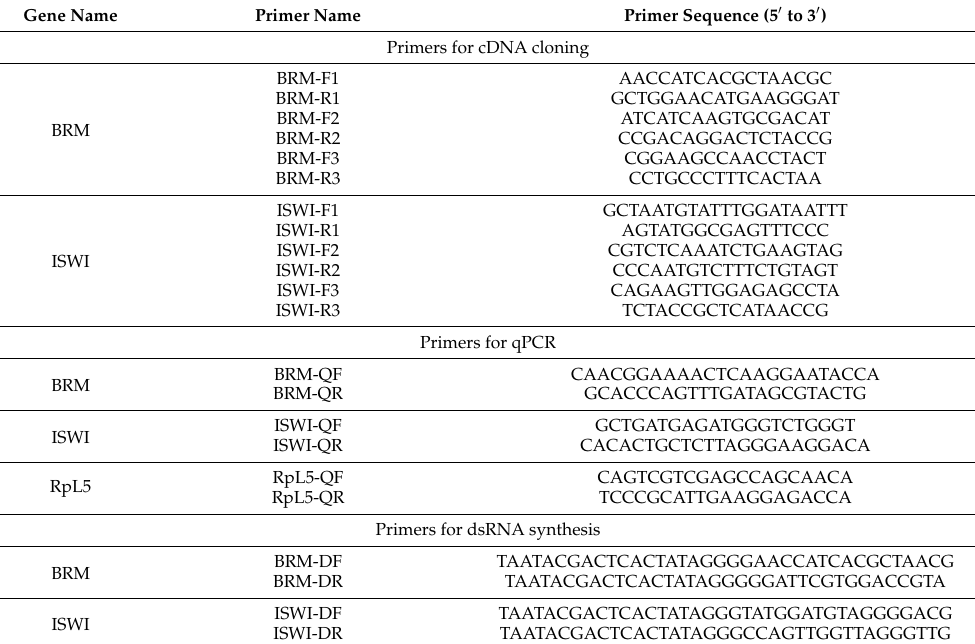
Table 1. Primers used for cDNA cloning, qPCR, and dsRNA